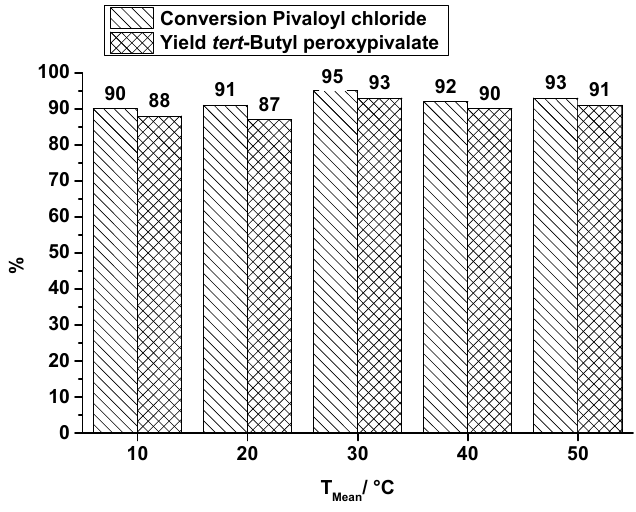
Figure 5. SAR reactor, conversion and yield of TBPP synthesis, 2nd reaction step at a total flow rate of 0.3 mL·min − 1 depending on the reaction temperature.